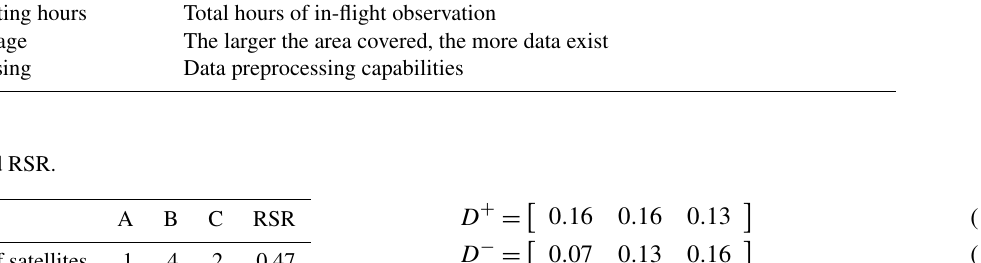
Table 3. Effectiveness indicators. Indicators Implication Spatial resolution of satellites The higher the resolution, the more accurate the disaster information obtained Flight preparation time Time required for preflight arrangements of aircraft Flight operating hours Total hours of in-flight observation Flight coverage The larger the area covered, the more data exist